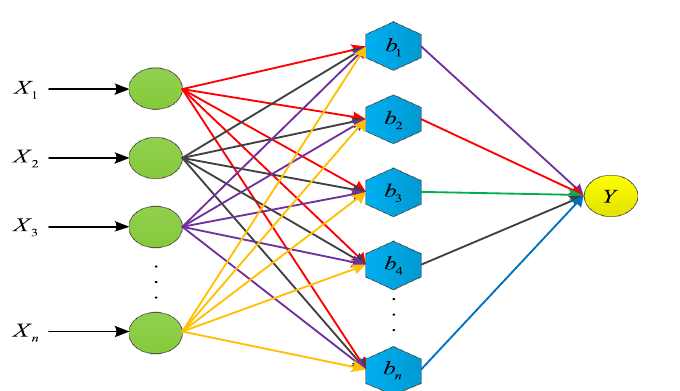
Figure 7. BP neural network